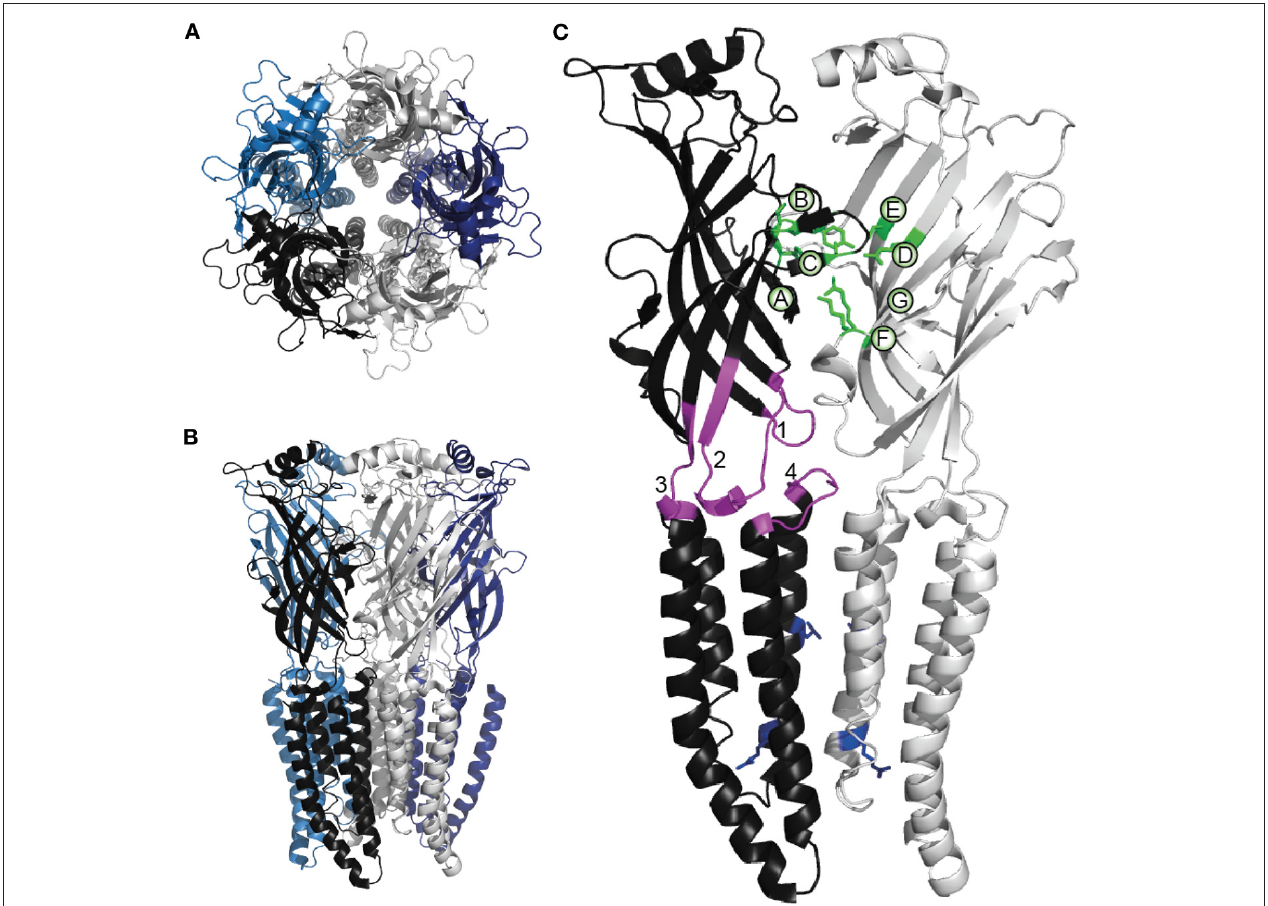
FIGURE 1 | Cys-loop receptor structure. The homomeric α GluClR from C. elegans viewed (A) from the extracellular space and (B) from within the membrane plane. Individual subunits are shown in different colors. (A) depicts the symmetrical arrangement of both the extracellular domains and, centrally, of the M2 helices. These images are based on the original X-ray crystallographic structure of 3.3 Å resolution (PDB ID 3RHW), which was achieved by complexing the GluClR with an antigen-binding fragment, ivermectin and lipids, and represents an activated, open-channel state (Hibbs and Gouaux, 2011). The present images were produced using PyMOL (Schrödinger, LLC). (C) Two adjacent subunits from (B) , indicating functionally